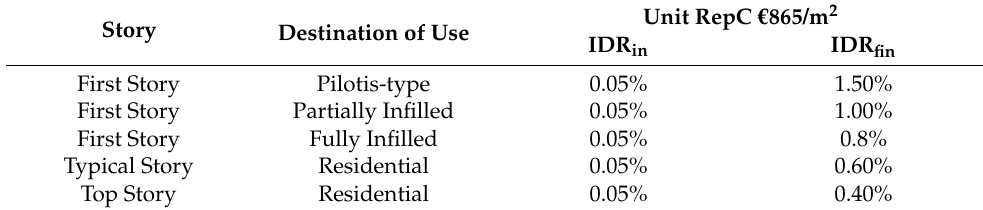
Figure 11. Story-based loss functions: example [3]. Table 9. Story-based loss functions: definition parameters.